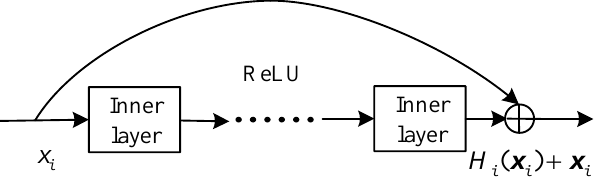
Figure 5. The structure of building blocks in the RCDNN model.